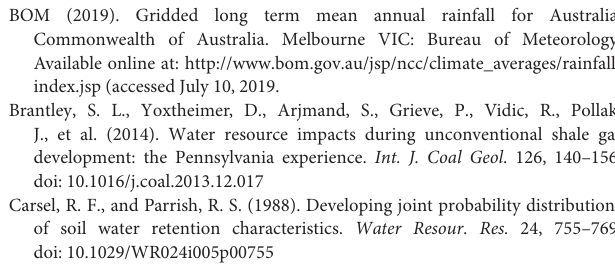
Supplementary Figure 2 | Contours of steady-state pressure head distribution and particle path lines for two extraction scenarios; a solute BTC was derived using 1D analytical solution for each path line